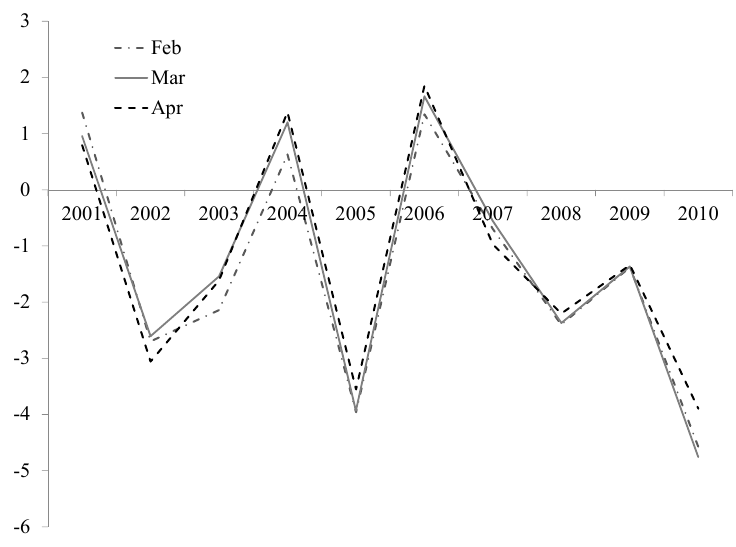
Figure S3. Palmer’s Drought index